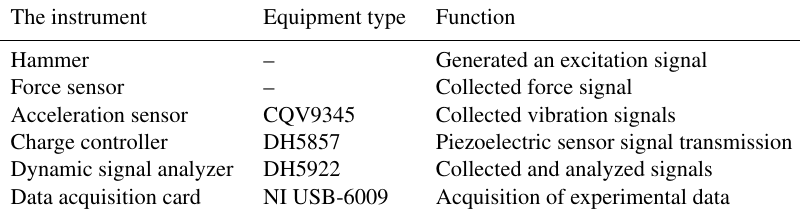
Table 1. Experimental